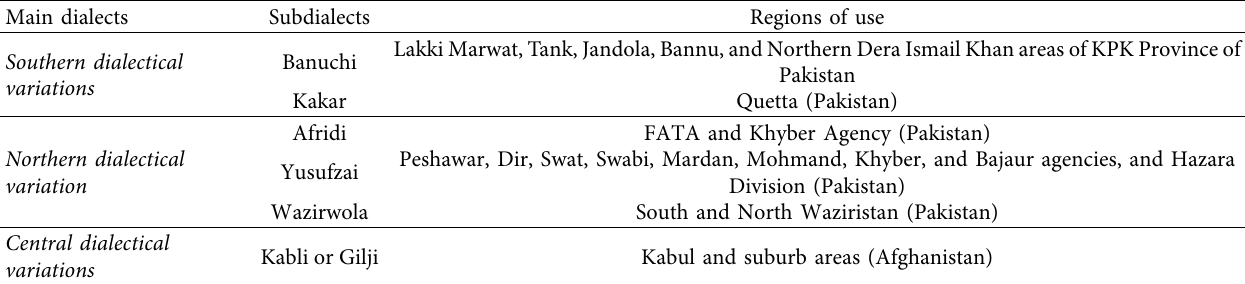
Table 1: Important subdialects of Northern, Southern, and Central variety of dialects and their regions of